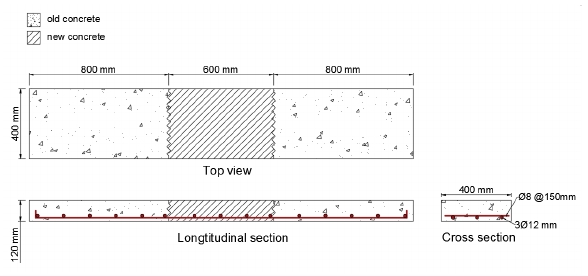
Figure 2: Dimensions and details of specimens ROWS2.